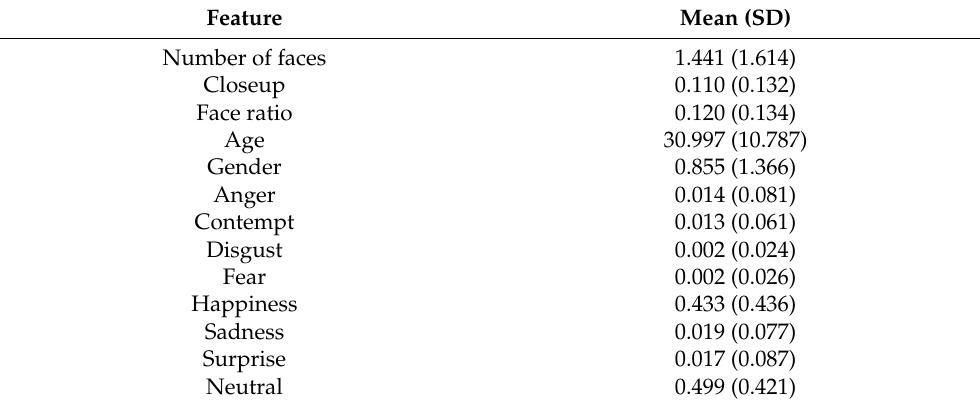
Table 1. The mean of facial features of the Instagram photos with a #NoMask